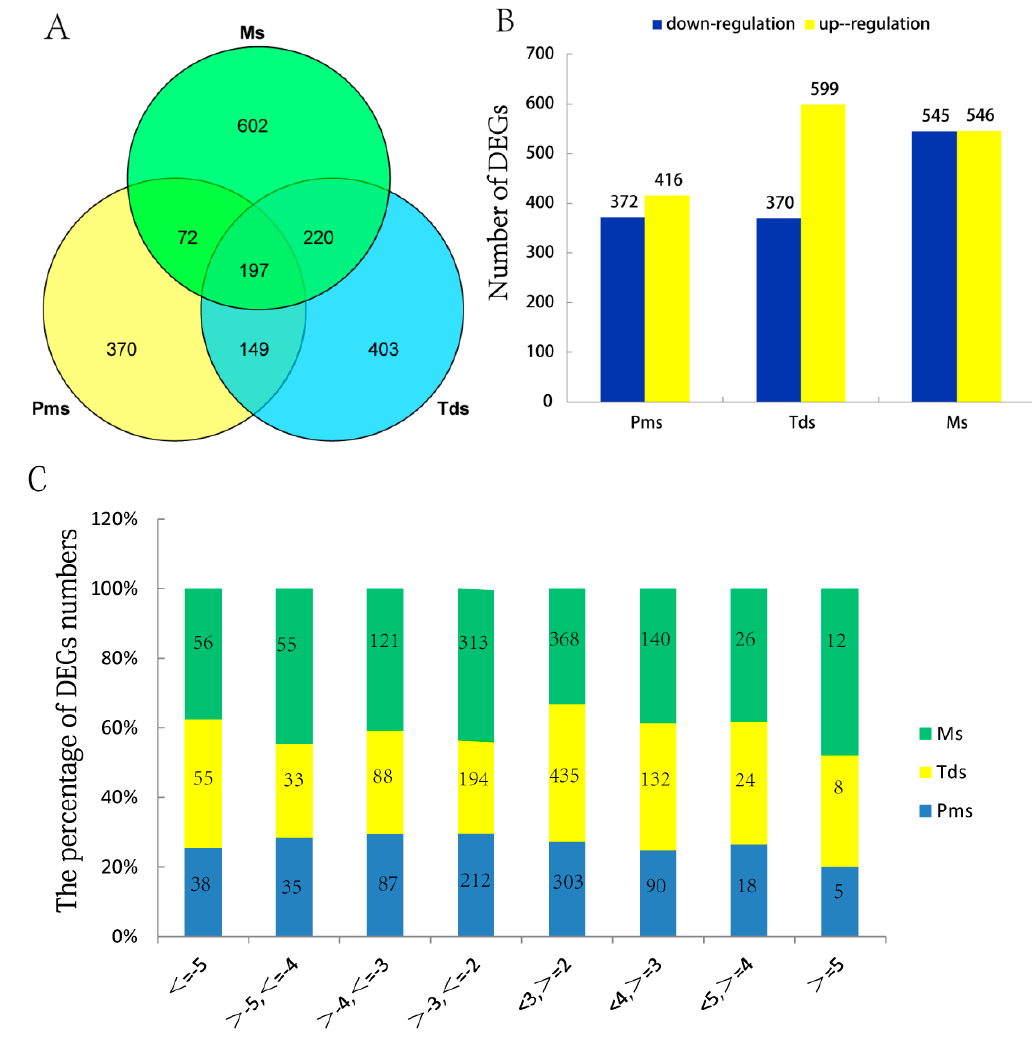
Figure 4. Analysis of DEGs in the male sterile line C2P5A compared to those of the maintainer line C2P5B from Pms to Ms stage of anther development. ( A ) Venn diagrams showing all DEGs shared among the three stages. ( B ) Number of DEGs that were up or down-regulated in the three development stages. ( C ) The distribution of the log 2 Ratio of DEGs in the C2P5A compaired to the C2P5B, Pms, Pollen mother cell stage; Tds, Tetrad stage; Ms, Mononuclear stage.